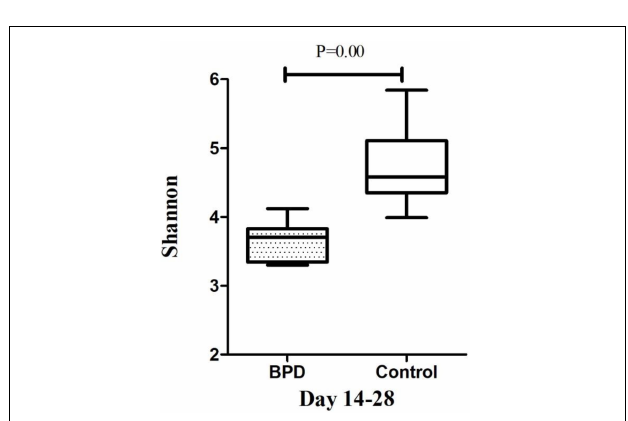
FIGURE 5 | The microbiome diversity of Shannon index between BPD group and Control group on days 14–28. Shannon index [M (P25–P75): 3.71 (3.34–3.83) vs. 4.58 (4.35–5.11), P =